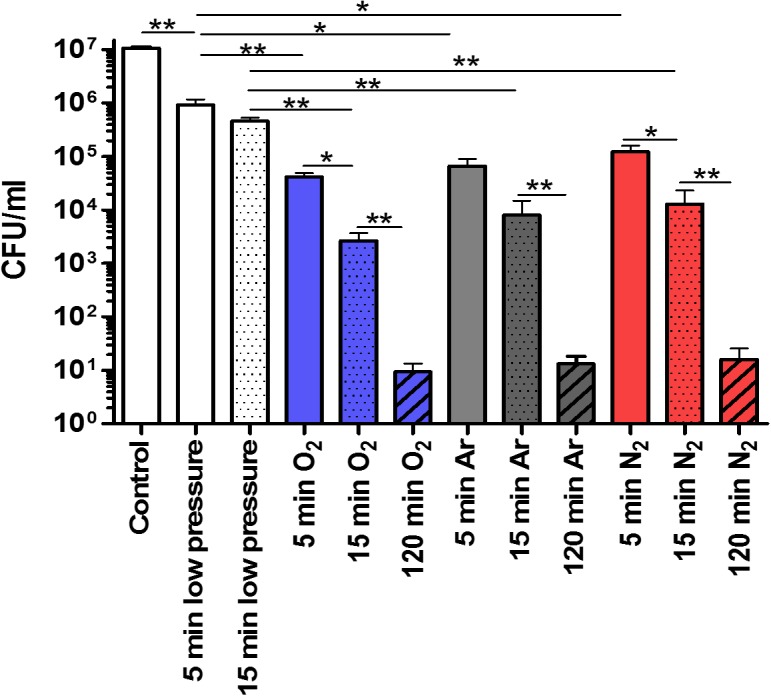
Inactivation of Staphylococcus aureus with N2, O2, Ar NTP (25 W; 14 G; and 0.5 sccm) determined by counting on agar plate. Error bars represent the standard error of the mean from seven experiments in triplicate. Statistical analysis was performed by the Wilcoxon test ∗p < 0.05; ∗∗p < 0.01.